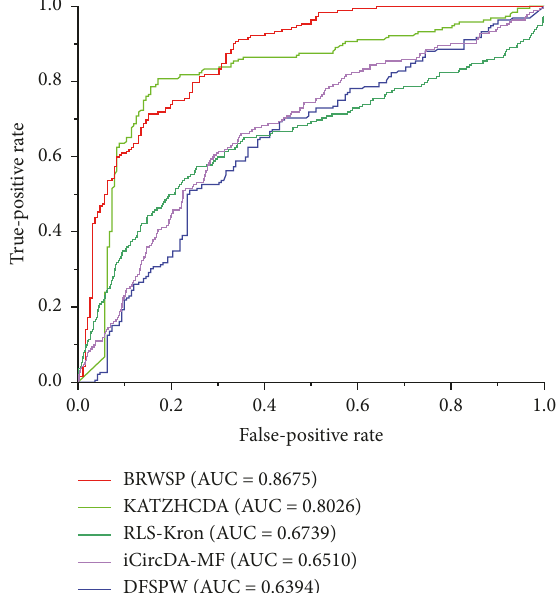
Figure 5: Comparison between BRWSP and other